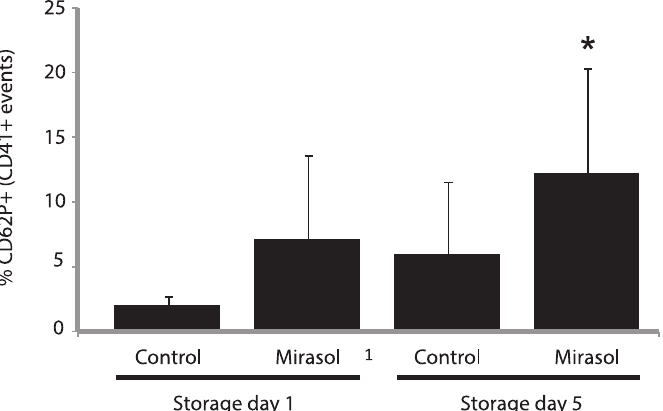
Fig 1. Platelet activation in control and Mirasol PRT-treated human platelets. P-selectin (CD62P) expression by human platelets on storage days 1 and 5 ± Mirasol PRT. * p < 0.05 vs. day 5 control. n = 4 – 6 per group. Mean ± SD.